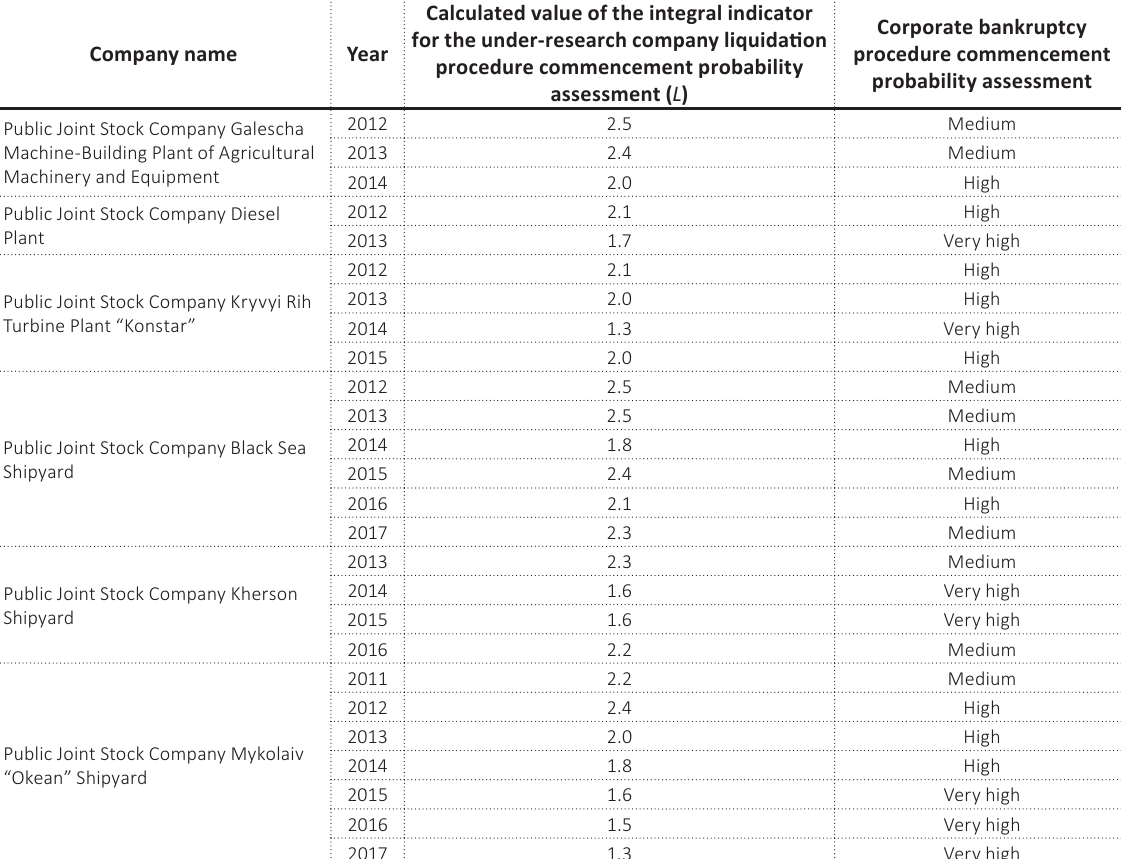
Table 7. Liquidation procedure commencement probability assessment for the Ukrainian shipbuilding and machine-building companies that are currently at the stage of bankruptcy, but whose liquidation procedure has not yet begun